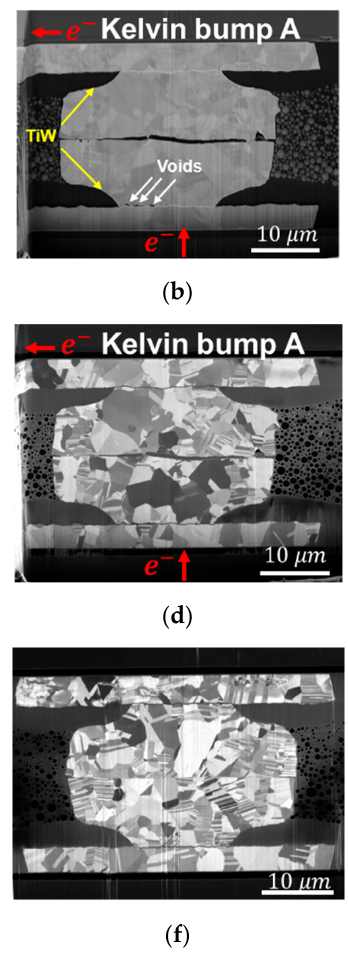
Figure 5. Destructive observation of the 31 MPa/10 s_K1 bumps. ( a , b ) Electron images of Kelvin bumps B and A, respectively. Voids are observed at the sites of current crowding. The voids form at the side of electron current passing through the TiW adhesion layer. In addition, the crack at the bonding interface of Kelvin bump A has caused an open circuit. ( c , d ) Ion images of Kelvin bumps B and A, respectively. In Kelvin bump B, grain growth across the bonding interface might be caused by the significant Joule heating before the open circuit of Kelvin bump A. ( e , f ) Electron image and ion image of a dummy bump,